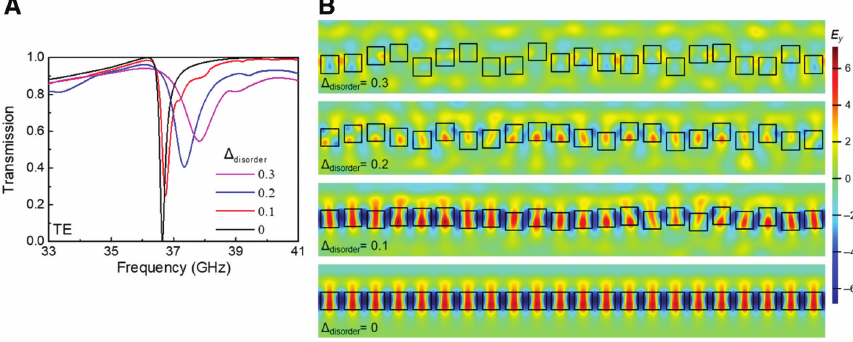
Figure 13: Simulation results. (A) Simulation spectra for TE-polarized transmission with different degrees of disorder. (B) Simulated electric field profiles (E profile of the guided resonance becomes more randomized as Δ dielectric lattice structure is induced by a coherent mode distributed over the whole lattice, not by localized resonances in individual beams. Adapted from Ref. [135]. Copyright (2019) John Wiley & Sons. more randomized. In the dielectric lattice structure, sharp Fano resonances occurred, because of guided resonances in the periodic, dielectric beams, which interfered with the slowly varying background Fabry–Perot resonance.